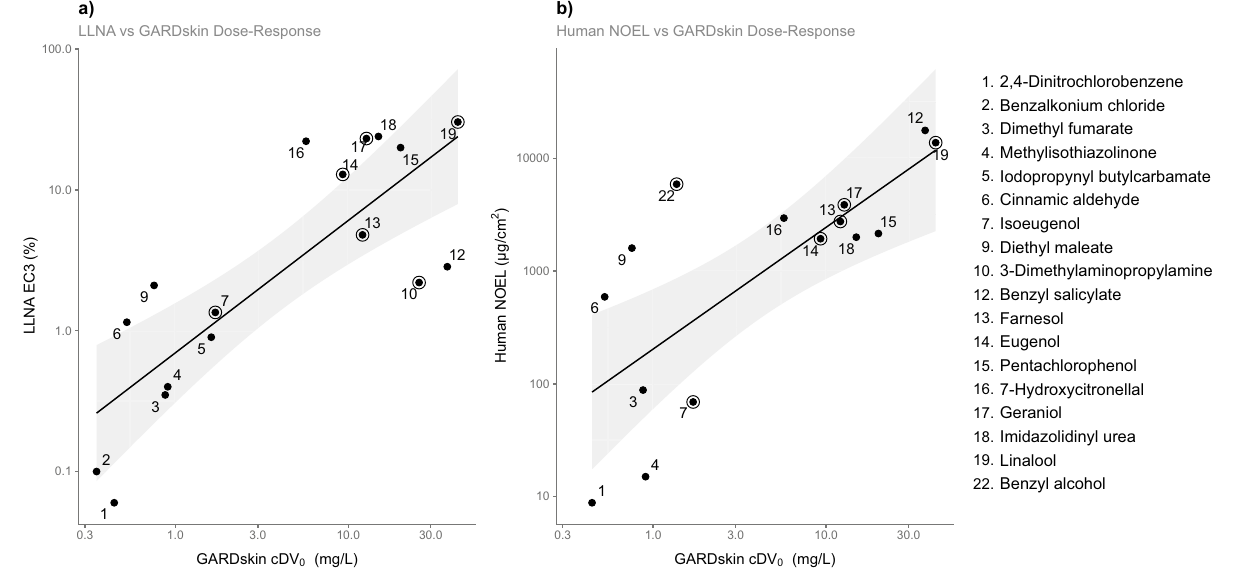
Figure 4. Performance assessment of GARDskin Dose–Response. Scatter plots displaying the relationship between estimated cDV 0 values and ( a ) LLNA EC3 values and ( b ) human NOEL values. The lines represent linear regression models fitted to the data, and the shaded areas describe the 95% confidence intervals of the fits. Encircled datapoints represent indirectly acting haptens. GARDskin cDV 0 is given in weight-based concentrations to facilitate comparison between potency